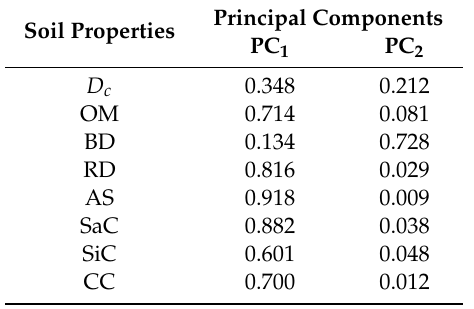
Table 4. Loadings of the original variables (soil properties and hydraulic parameters) on the first two Principal Components (PC 1 and PC 2 ) for the four land uses (cropland, grassland, woodland, and forestland) of the Saravan watershed (Northern Iran). Principal Components Soil Properties PC 1 PC 2 D c 0.348 0.212 OM 0.714 BD